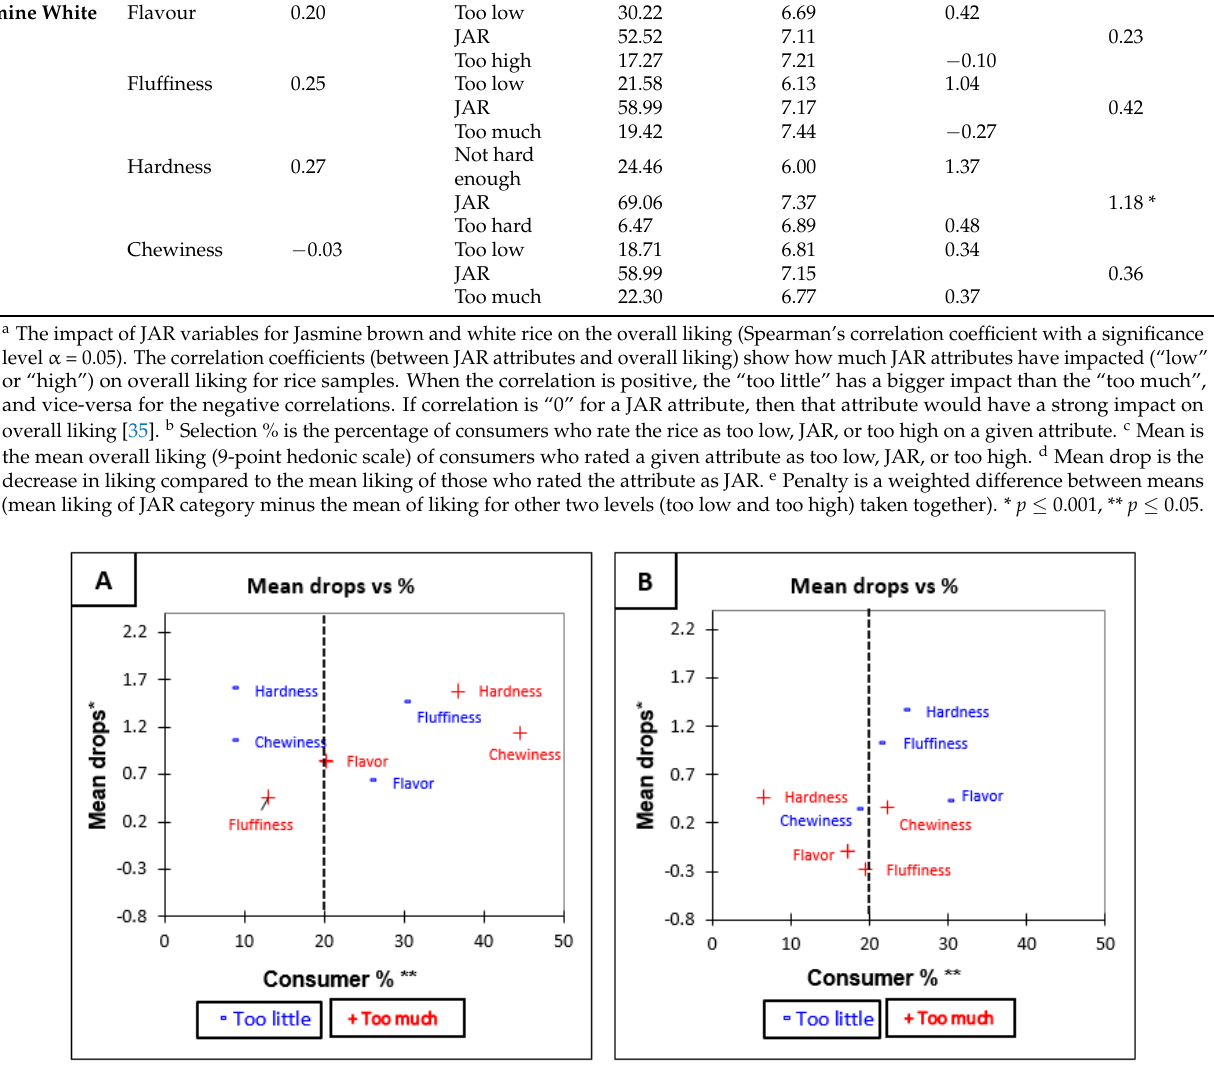
Figure 5. Mean drop plots for Jasmine rice variety after tasting ( A ) Jasmine Brown and ( B ) Jasmine White. * Mean drop is the decrease in liking compared to the mean liking of those who rated the attribute as JAR. ** Consumer % are the consumers which judged an attribute as not ideal (Just About Right). The attributes with large percentages of consumers and penalties are in top right quadrant of the plot, which illustrates the critical points of the product [34]. Table 8. The Penalty analysis and JAR variables (after tasting) for Jasmine brown and Jasmine white rice.